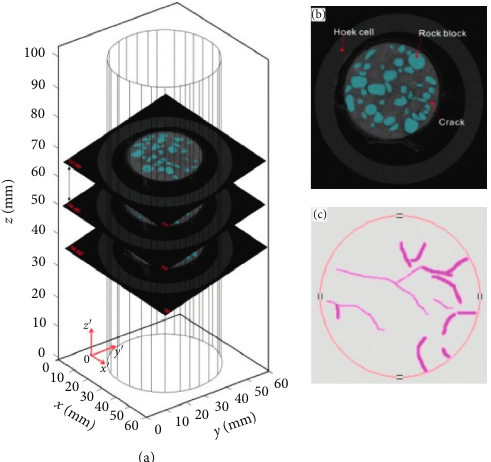
Figure 2: The sample grayscale image data is a bimrock sample. (a) BMP image stack; (b) extraction of the 28th layer of CT; (c) ex- traction of CT slice cracks.